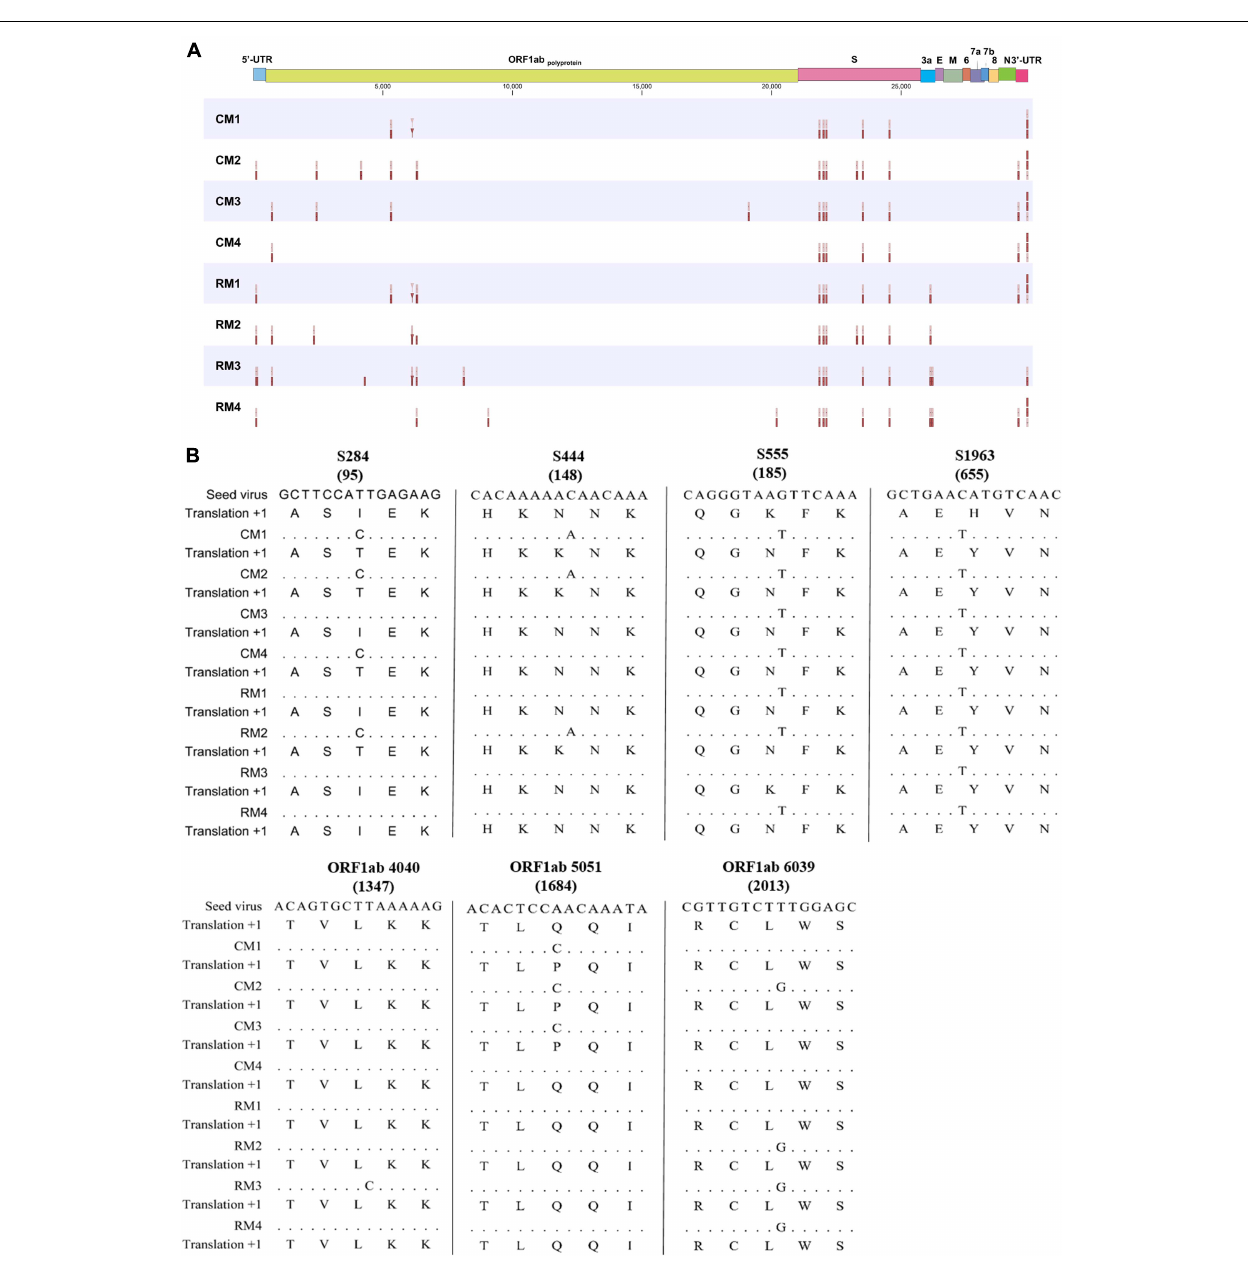
identified in the ORF1ab gene. The differences at six